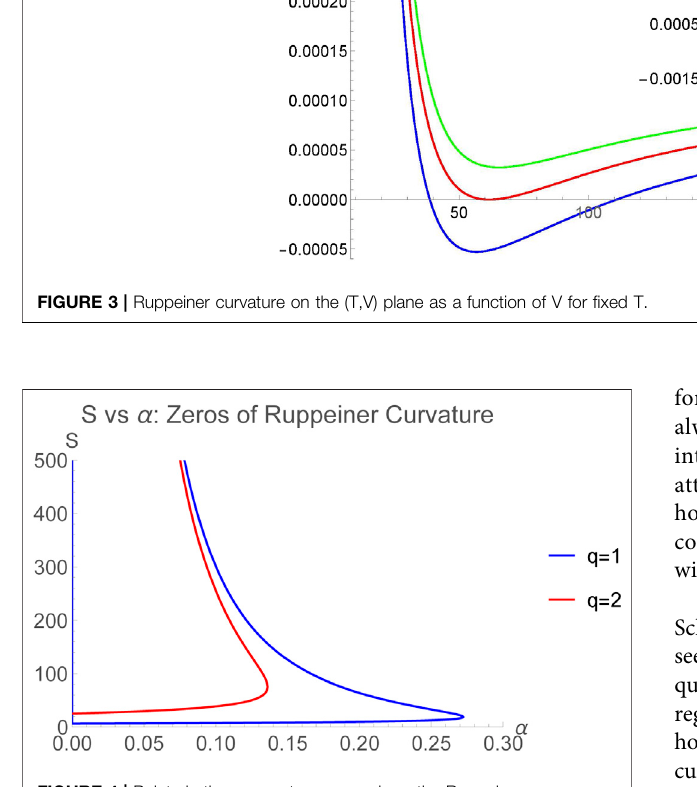
6 Indicating that the smaller black holes are dominated by repulsive interactions among microstructures